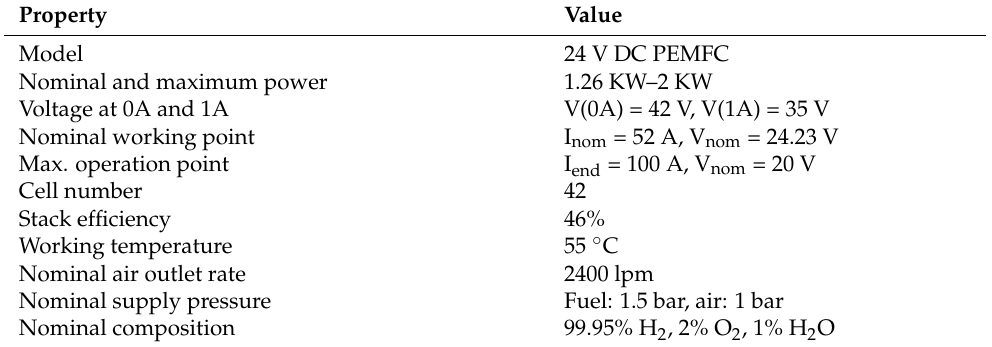
Table 3. Specification of PEMFC